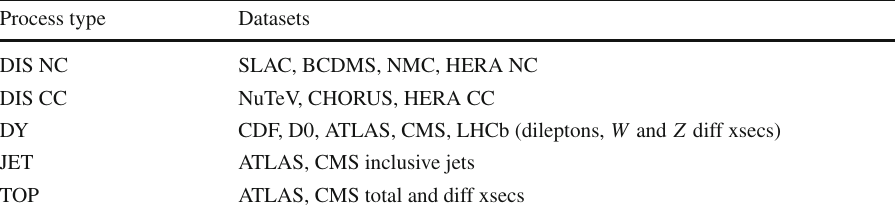
arranged in the order given in Fig. 7 below: so SLAC data are in the top left corner, and LHC top data in the lower right corner